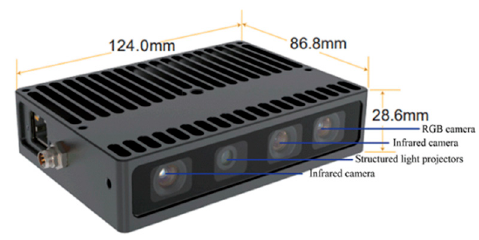
Figure 8. Structure of Percipio FM851-E2.